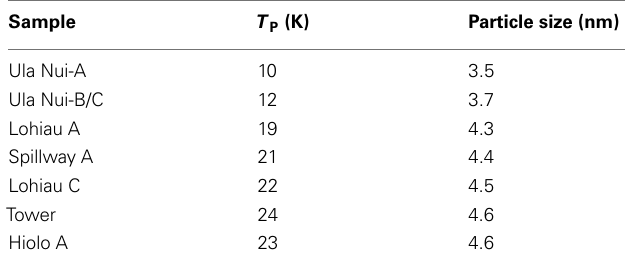
Table 4 | Peak temperature obtained from ZFC curves and the corresponding particle size estimate using Néel–Arrhenius law.